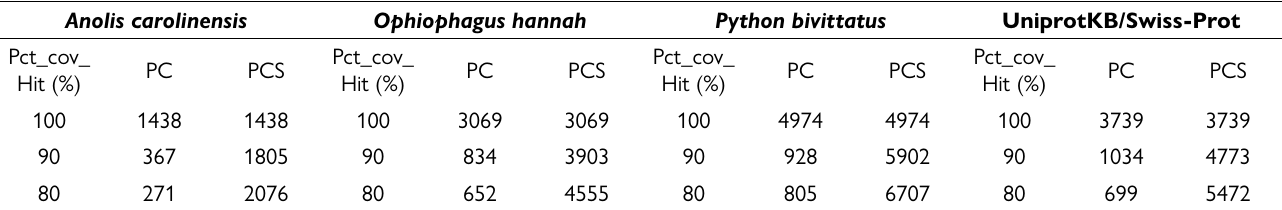
Table 3. Full-length transcript reconstruction analysis of B. jararaca venom gland transcriptome in relation to Anolis carolinensis , Ophiophagus hannah, Python bivittatus and UniprotKB/Swiss-Prot. Anolis carolinensis